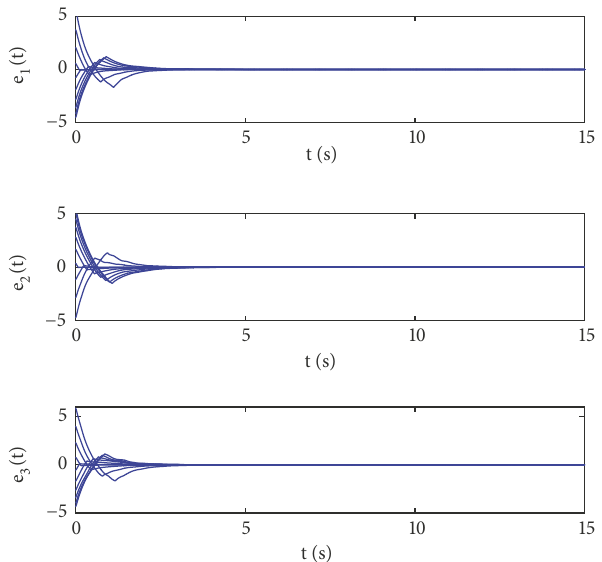
Figure 11: Select 10 random initial conditions and state trajectories of the synchronization errors 𝑒 1 (𝑡) , 𝑒 2 (𝑡) , and 𝑒 3 (𝑡) with 𝜉 = 3